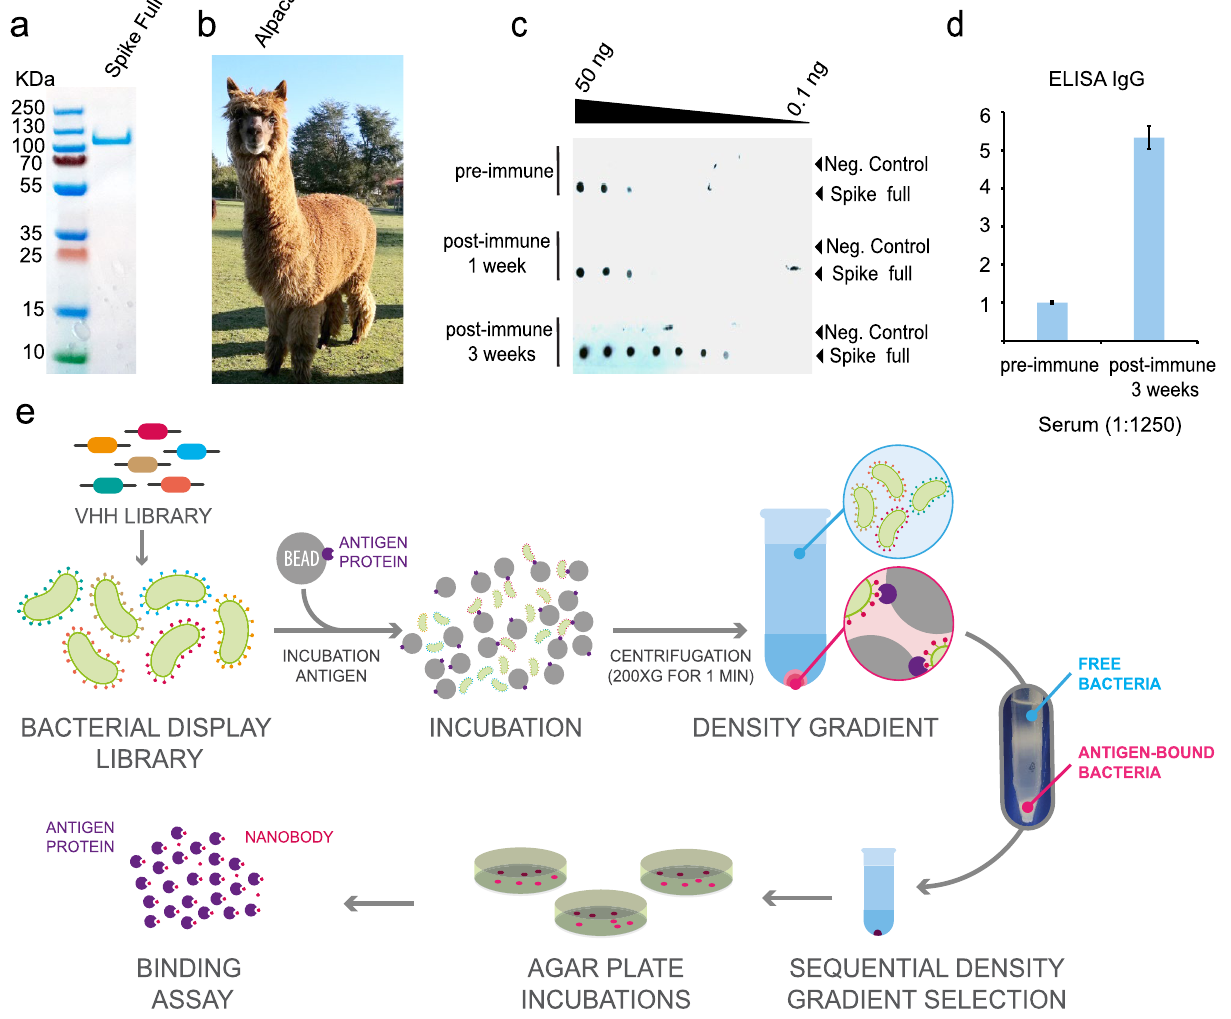
Figure 1. Immunization of the spike of SARS-CoV-2 and a simple density gradient method for the selection of nanobodies. (a) SDS-Page to ensure protein integrity of full-length spike of SARS-CoV-2 before immunization. ( b) Adult alpaca immunized with spike . (c) Evaluation of the alpaca´s immune response by dot blot. Image shows the reaction to decreasing amounts of Spike and bovine serum albumin (negative control) using a pre- immunization control, and after one immunization (1 week), or two immunizations (3 weeks) with full-length SARS-CoV-2 spike, using alpaca serums as a primary antibody source followed by an anti-camelid IgG-HRP secondary antibody. (d) ELISA before and after the second immunization (3 weeks) n = 4 error bars indicate standard deviation statistic t-test, ** P ≤ 0.005. (e) Schematic representation of novel protocol for isolation of nanobodies using density gradient separation. The bacterial display library expressing the nanobodies on the surface of bacteria is briefly incubated with conventional sepharose beads coated with the antigen of interest. Directly after the mixture is deposited on a Ficoll gradient conic tube and centrifuged at 200 g for 1 min, the beads drive through the gradient to the bottom of the tube with the bacteria expressing specific nanobodies, while unbound bacteria remain on the surface of the gradient. The beads are then resuspended, and bacterial clones are isolated for biochemical binding confirmation. Illustration (e) by Felipe G. Serrano BSc., MSc Scientific